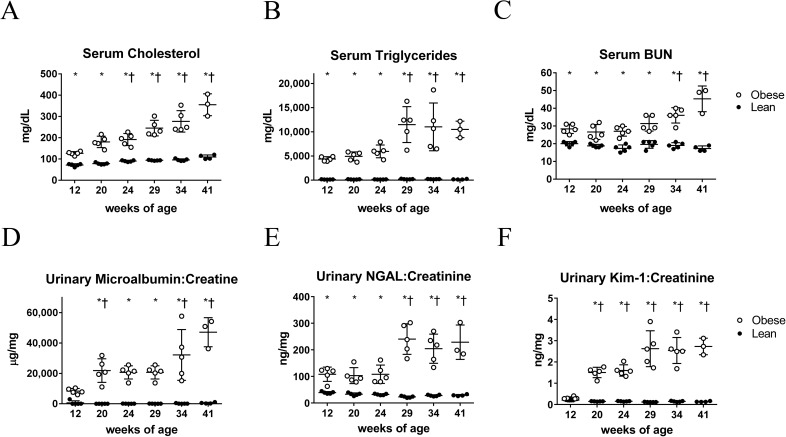
Obese ZSF1 rats have metabolic syndrome and evidence of renal impairment by 12 weeks of age.(A) Serum total cholesterol, (B) serum triglycerides, (C) serum blood urea nitrogen (BUN), (D) urinary microalbumin to creatinine ratio, (E) urinary NGAL to creatinine ratio, and (F) urinary Kim-1 to creatinine ratio in lean and obese animals over the study duration. Each point represents a single animal, with obese animals represented by open circles and lean animals represented by filled circles. Statistical analyses, here and in subsequent Figures, are for each obese group versus age-matched lean group (denoted by *) or for each obese group versus the 12-week-old obese group (denoted by †) using two-way ANOVA Tukey’s multiple comparisons tests.